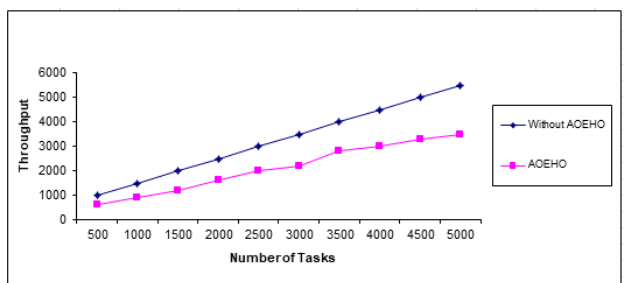
Figure 17. Throughput time for tasks.